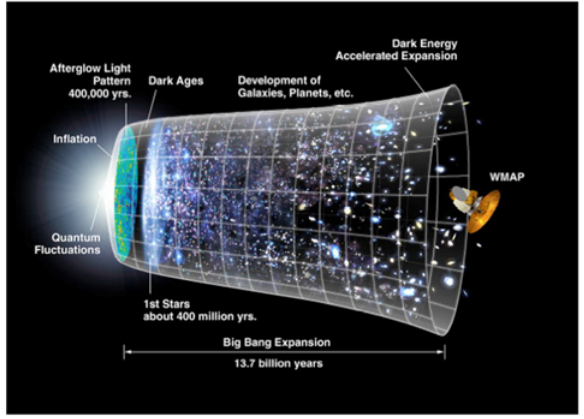
Figure 2. “Time Line of the Universe” The time-dependent structure of the universe in four dimensions—three spatial ( x , y , z ) and one time ( t )—is expressed in a pseudo-3D image by ignoring one spatial dimension and replacing the horizontal spatial coordinate by the time coordinate. Graphic courtesy of NASA: may be freely used for educational and informational purposes